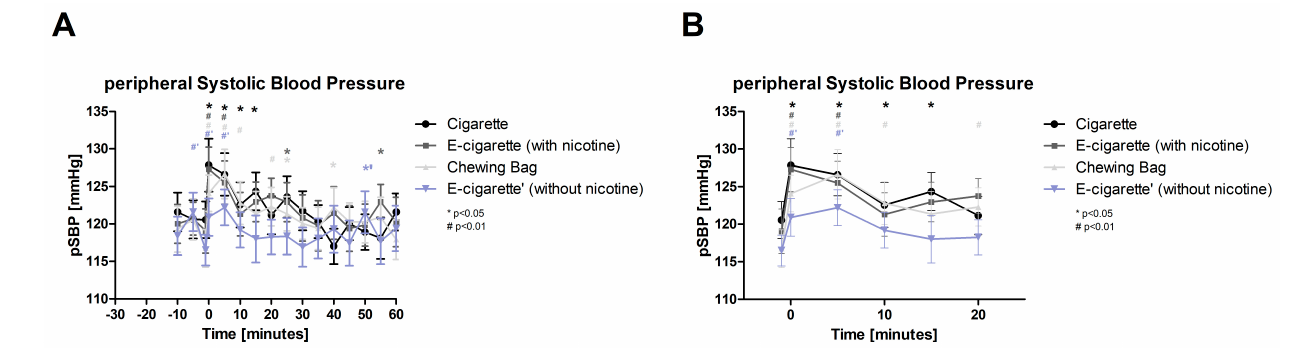
shows the highest increase with 7% followed by Chewing bag with 6.5% after 5 min. With less than a 1% increase, E-Cig (-) shows a very slight change related to the intervention.